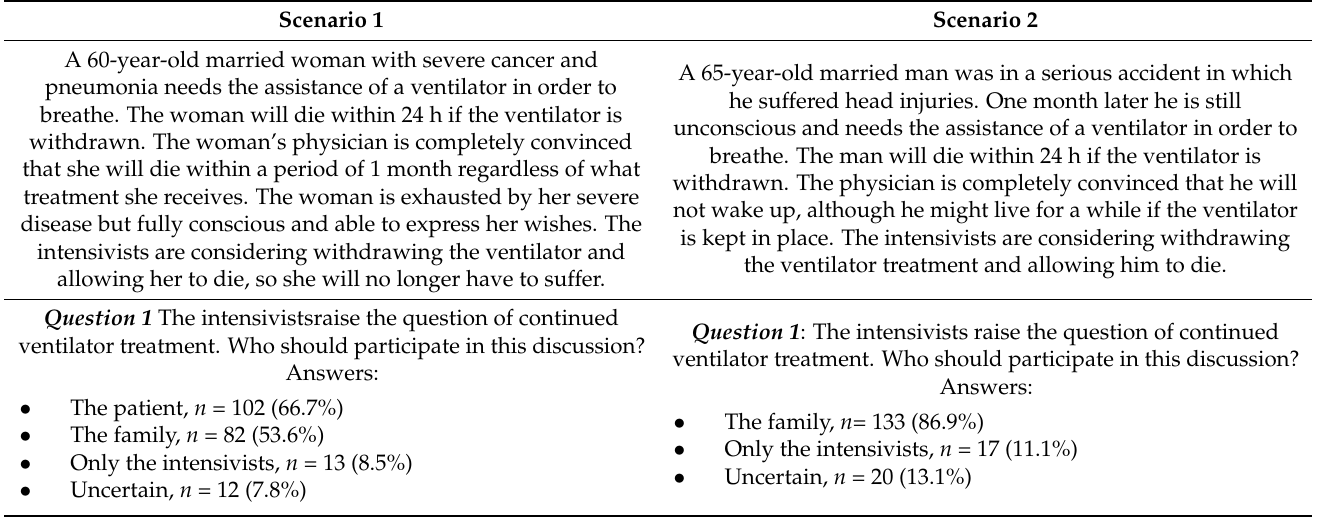
Table 6. The hypothetical clinical